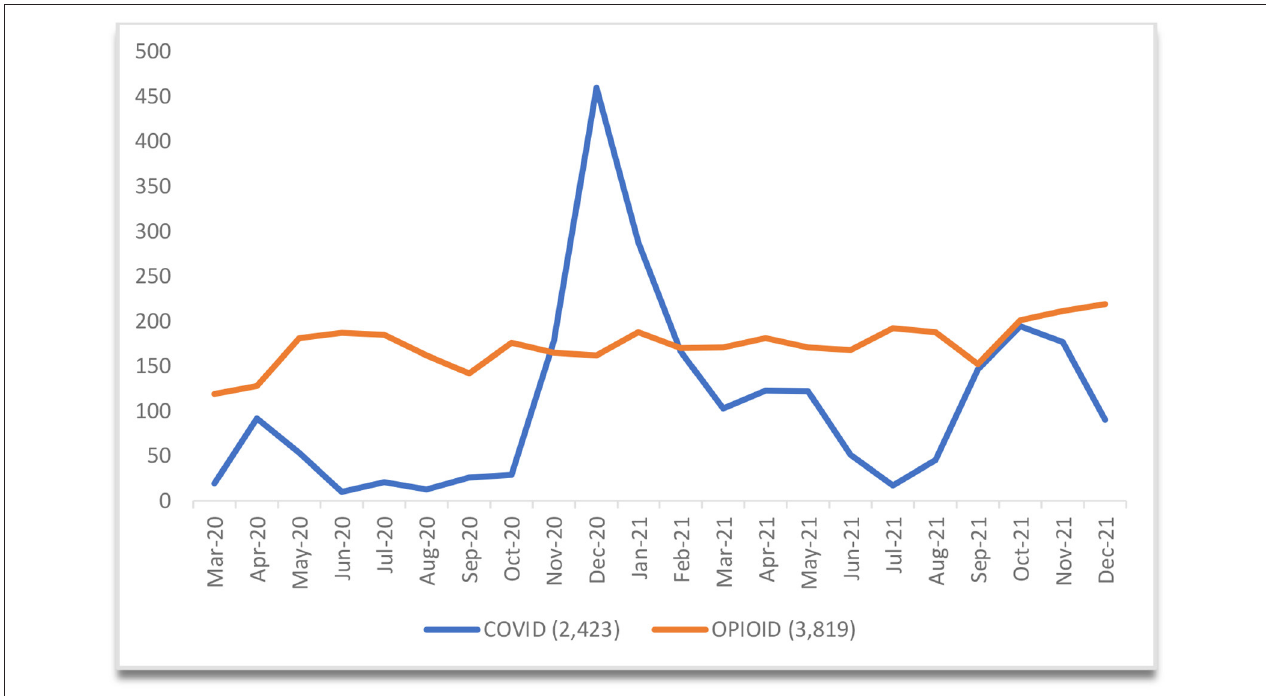
FIGURE 1 | Opioid-related and COVID-19 Deaths in B.C. Between March 1, 2020 and December 31, 2021. B.C.’s first recorded COVID-19 death was March 8, 2020. B.C. reports COVID-19 deaths daily (Mon-Fri) (B.C. Centre for Disease Control, n.d). B.C. reports “confirmed and suspected illicit toxicity deaths” once per quarter ( B.C. Coroners Service,